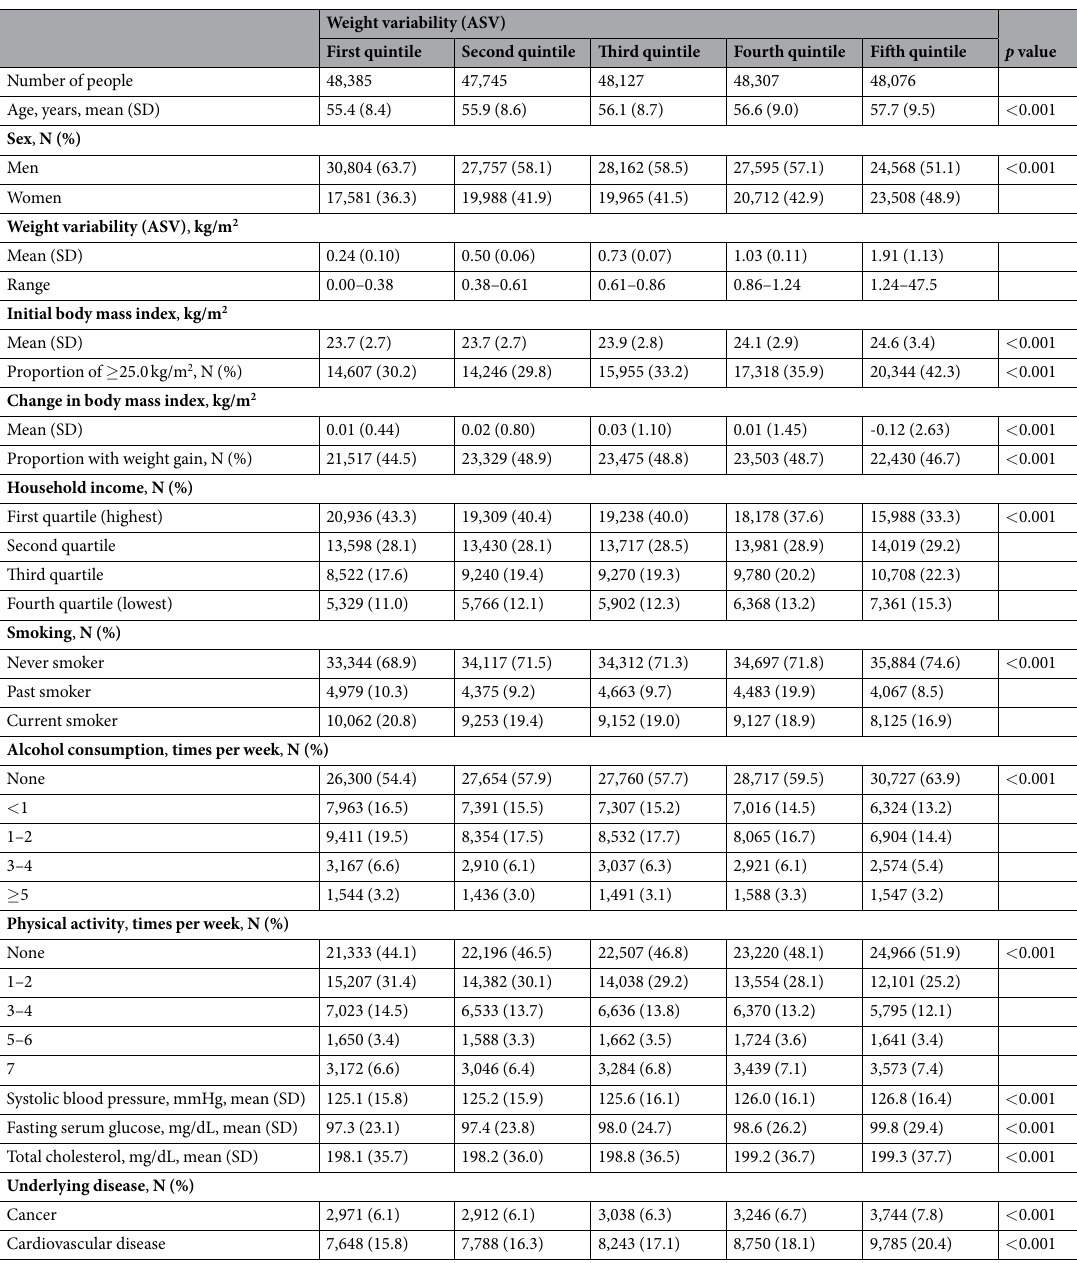
Table 1. Descriptive characteristics of the study population. p value calculated by Chi-squared test for categorical variables and analysis of variance for continuous variables. Acronyms: ASV, average successive variability; SD, standard deviation; N, number of